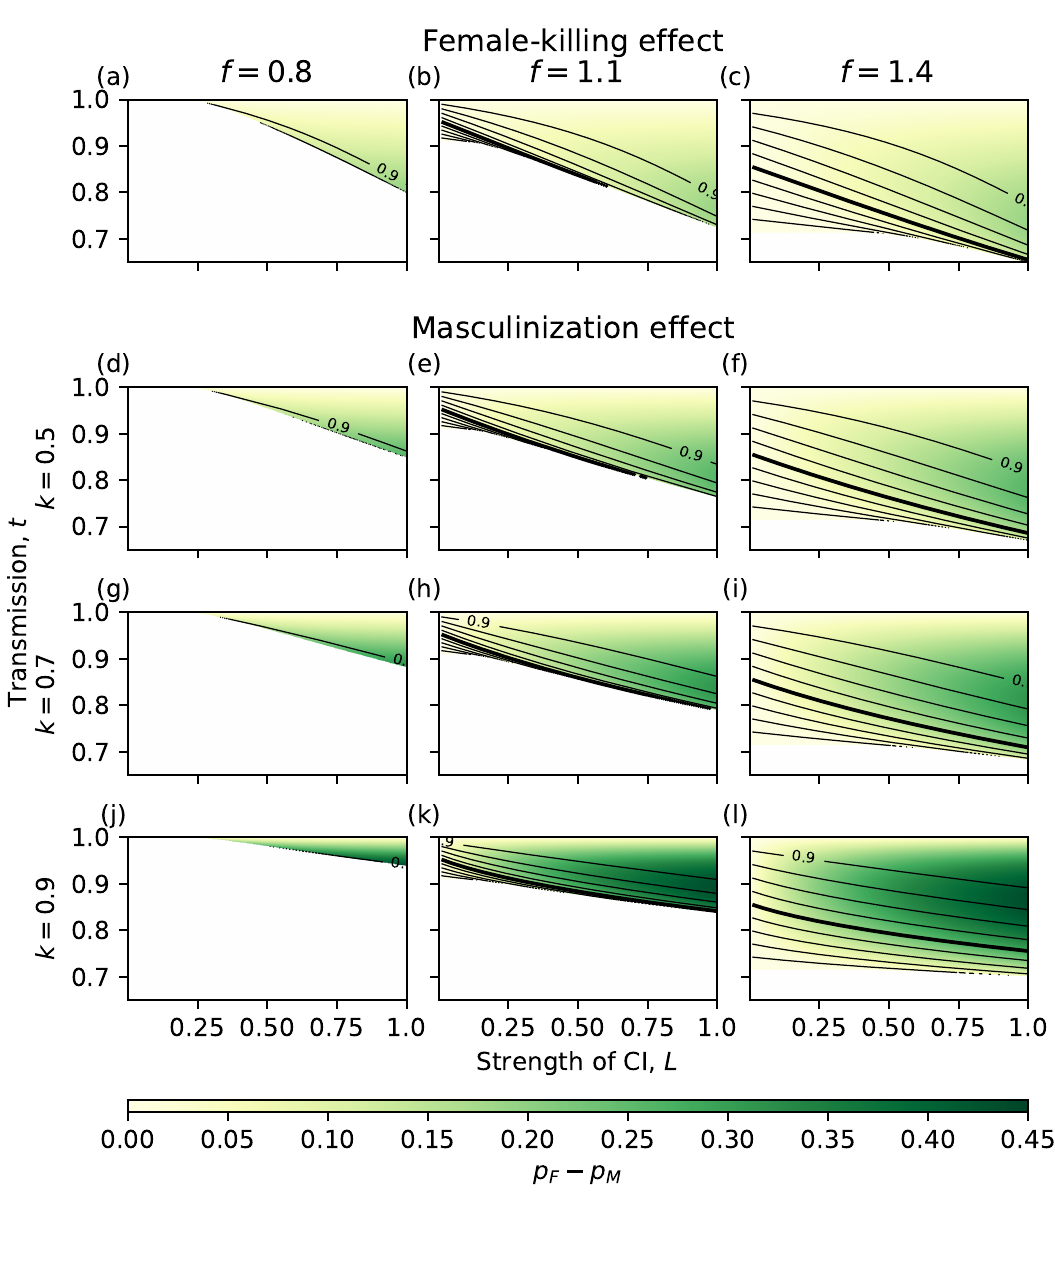
Figure 7. Equilibrium infection frequencies of the haplodiploid models across parameter space. Columns from left to right with f = 0 . 8 , f = 1 . 1 and f = 1 . 4 . First row: female-killing effect; other rows: masculinization effect model with different values of k . Black contour lines show infection frequency in females (with gaps of 0.1), while the color shows difference between female and male infection frequency according to the colorbar in the bottom. Thick solid contour marks one half frequency. Females always have higher infection frequency than